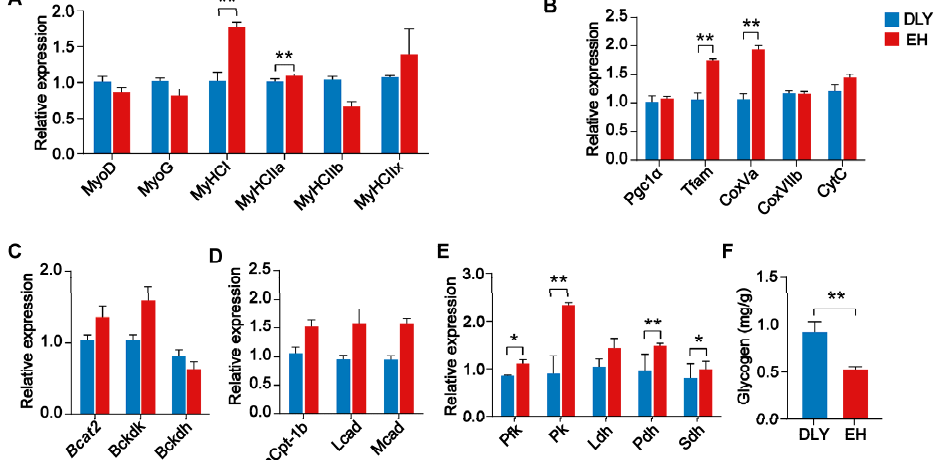
Figure 2. Relative mRNA expression of genes in the longissimus dorsi of DLY and EH pigs. ( A ) Expression of the skeletal muscle-specific transcription factors, MyoD and MyoG , which encode myosin heavy chain ( MyHC ) isoforms, namely, the MyHC I , MyHC IIa , MyHC IIb , and MyHC IIx genes. ( B ) Expression of the PGC-1 α , Tfam , CoxVa , CoxVIIb , and Cyt c genes related to mitochondrial function. ( C ) Expression of the Bcat2 and Bckdk genes involved in branched-chain amino acid catabolism. ( D ) Expression of the Pfk , Pk , Ldh , Pdh , and Sdh genes, which are involved in glucose metabolism. ( E ) Expression of the mCpt-1b , Lcad , and Mcad genes involved in the fatty acid oxidation pathway. ( F ) Glycogen concentration. The data were expressed as the means ± SEM; * p < 0.05, ** p < 0.01.